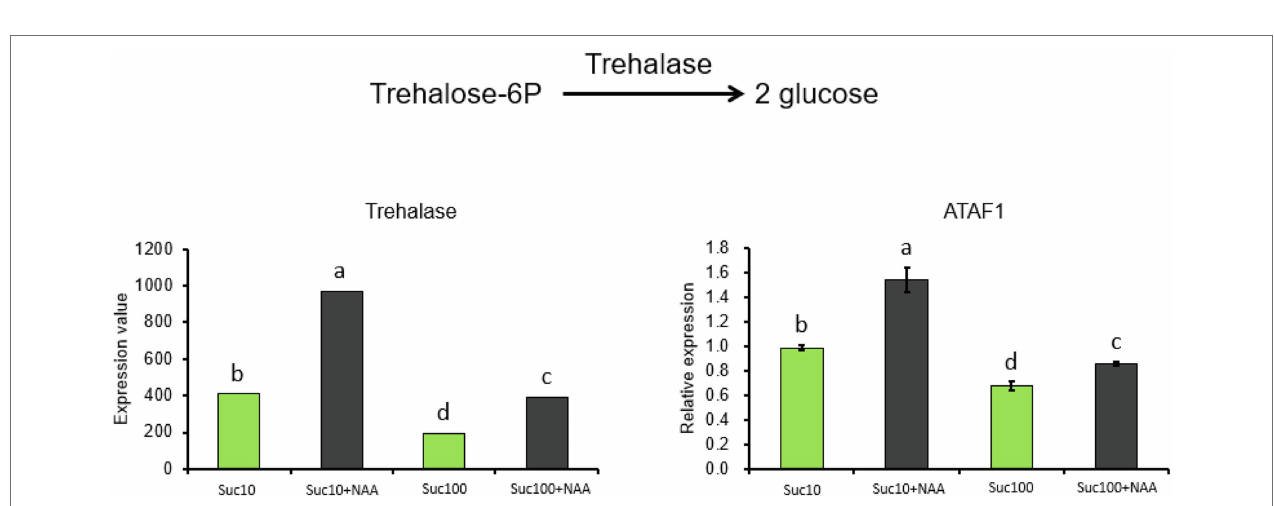
FIGURE 3 | Expression level of No APICAL MERISTEM/ARABIDOPSIS TRANSCRIPTION ACTIVATOR FACTOR/CUP-SHAPED COTYLEDON ( ATAF1 ) and Trehalase in in vitro -cultured buds supplied with different treatments. Suc10, 10 mM sucrose; Suc10 + NAA, 10 mM sucrose + 1 μ M NAA; Suc100, 100 mM sucrose; and Suc100 + NAA, 100 mM sucrose + 1 μ M NAA. Data are the means ± SEs of three biological replicates. Letters, significant differences between the different treatments with p <